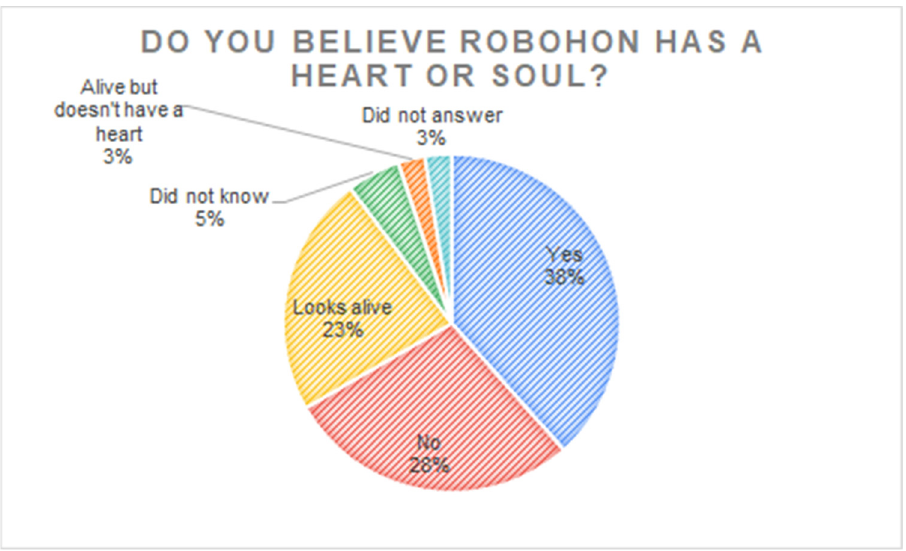
Figure 5. Responses on whether the owners believed Robohon had a heart or soul (Source: Prepared by the authors).